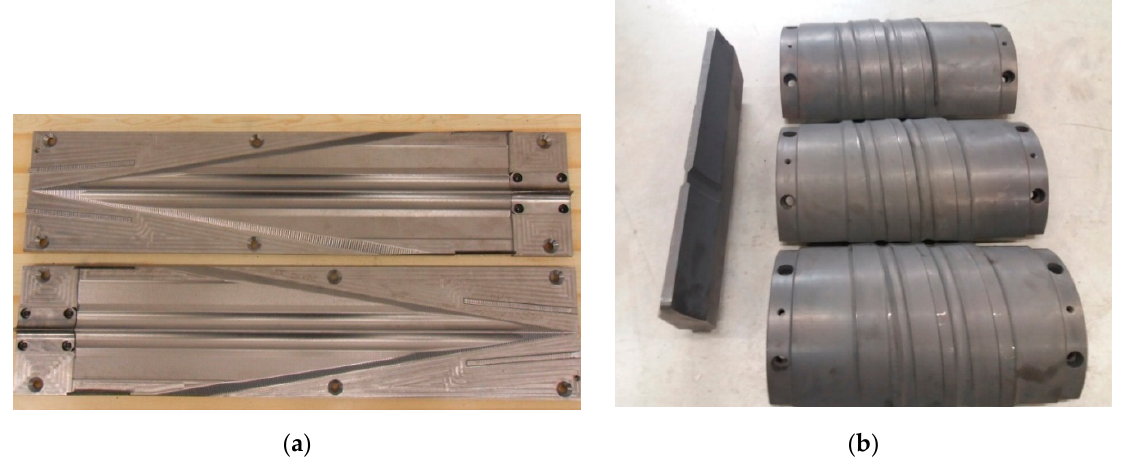
Figure 3. Tools used in: ( a ) cross-wedge rolling (CWR); ( b ) helical-wedge rolling (HWR).